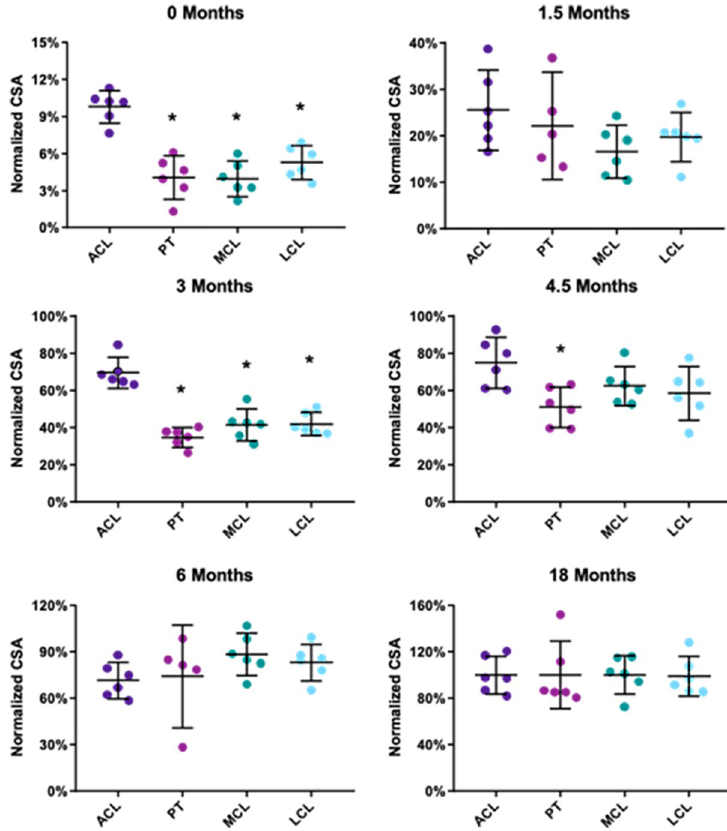
Fig 5. Tissue CSA data compared across tissues at each age normalized to the late adolescent group. CSA is significantly greater in the ACL compared to the other tissues (p < 0.05) at ages including 0, 3, and 4.5 months. Data for individual specimens are presented as points while mean and 95% confidence intervals are represented by dashes and lines. � denotes p < 0.05 from